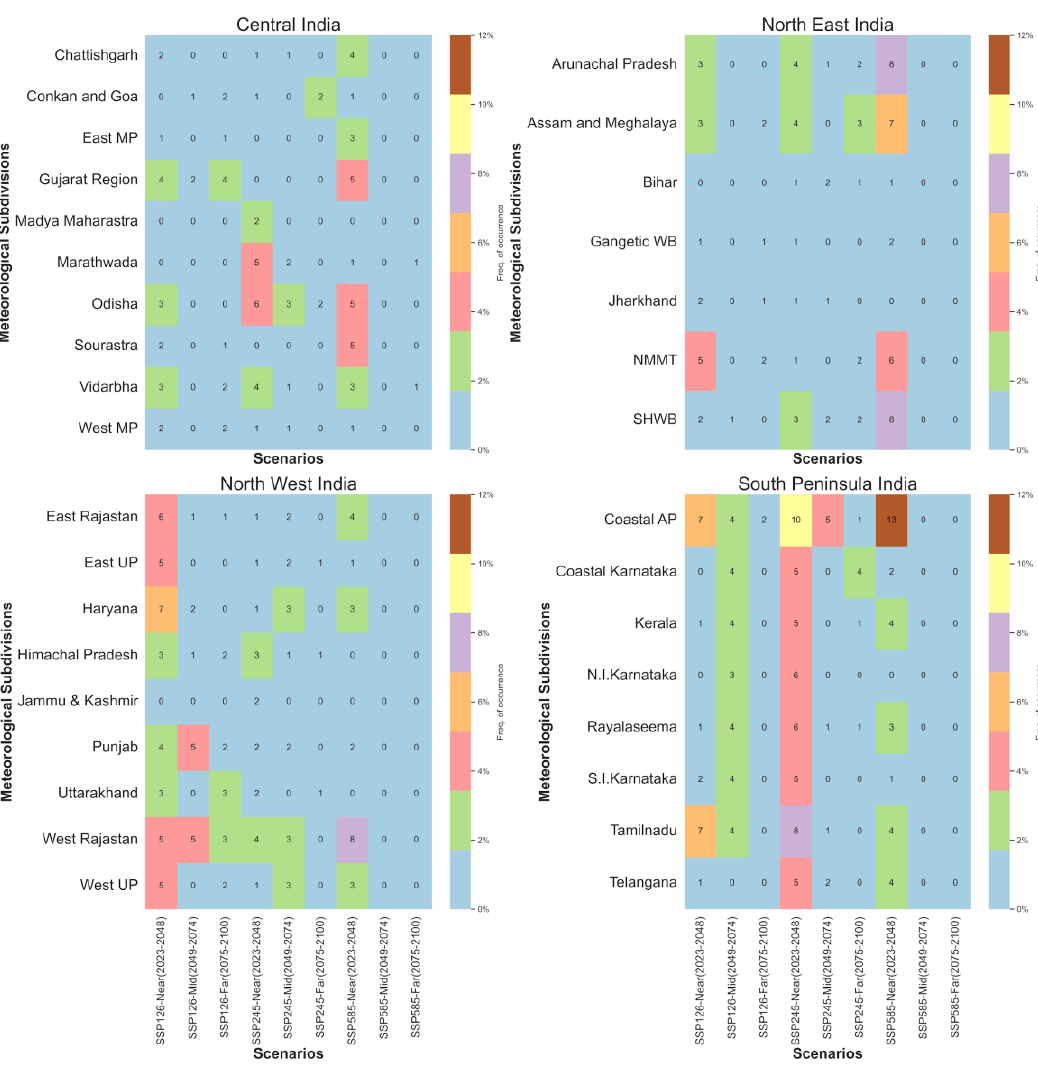
Figure 13. Frequency of occurrence (%) of drought events (12-month SPI ≤ − 1.0) at met subdivision level during the southwest monsoon months (June to September).